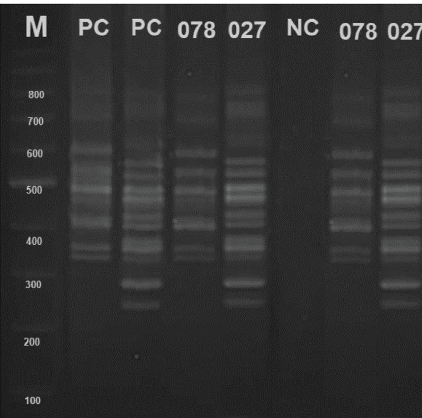
Figure 2: A sample of ribotyping profle of C. difcile strains isolated from raw meat and surface carcass swab samples. M: ladder (100 bp, roche diagnostics, Mannheim, Germany), the frst PC: positive control for the 078 ribotype ( C. difcile 078-M16, Statens, Denmark), the second PC: positive control for the 027 ribotype ( C. difcile 027-F62, Statens, Denmark), 078: positive samples for the 078 ribotypes, 027: positive samples for 027 ribotype, NC: negative control (PCR-grade water, roche diagnostics, Mannheim, Germany).